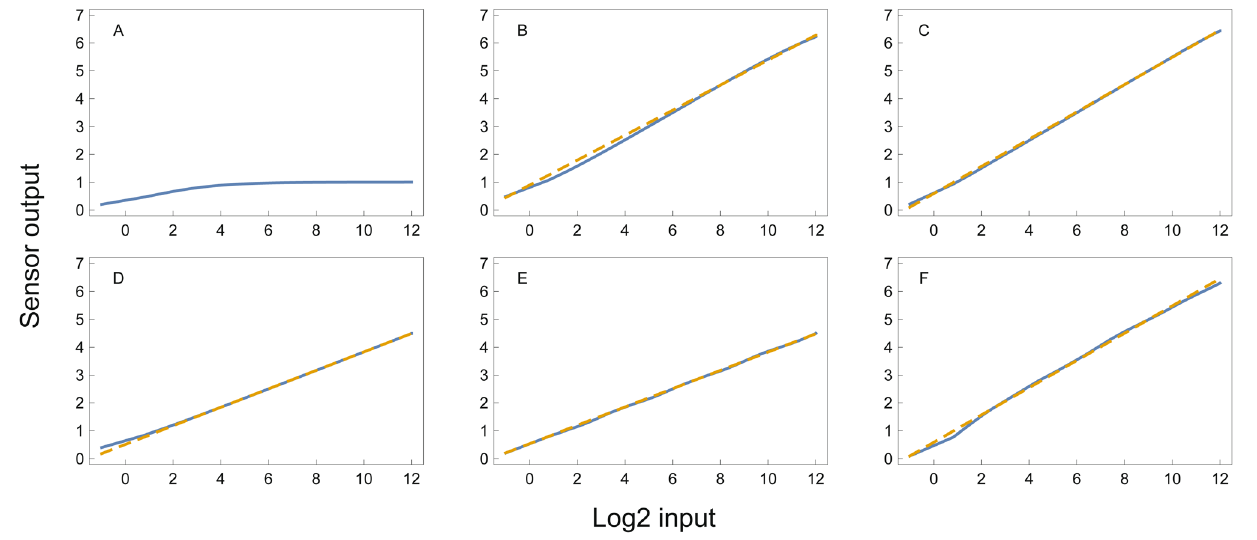
Figure 1. The logarithmic sensor response, y , from the sum of Hill equations given in Equation 1, versus the logarithm of the input, scale. Each unit on the input scale corresponds to a doubling of the input. The range of 13 doublings is approximately four x , on a log 2 orders of magnitude, 2 13 ≈ 10 4 . A logarithmic sensor responds linearly with respect to the logarithm of the input. The solid blue lines show the response, y , from Equation 1. The dashed gold lines are linear fits to the response. ( A ) A single Hill equation with c = 1 and k = 2. A linear response with low sensitivity occurs over a few doublings at small input levels. The following plots all use n = 7 and additional parameters as described from the summed Hill equation in Equation 1, in which c = b i . ( B ) Response with k = 1 and b = 4. ( C ) Response with k = 2 and b = i 4. ( D ) Response with k = 1 and b = 8. ( E ) Response with k = 2 and b = 8. ( F ) Same average parameters values of k = 2 and c = b i for b = 4 i as in the plot above, but with random parameter fluctuations around those average values. For each of the 7 Hill equations in the sum given in Equation 1, each parameter was obtained by a different random number drawn from a normal distribution. For each k , the parameters were drawn from a normal distribution with mean 2 and standard deviation 2 × 0.25 = 0.5. For each c , the parameters were drawn from a normal i distribution with mean 4 i and standard deviation 4 i ×0.25. The response remains nearly linear in spite of the random parameter fluctuations (see Data